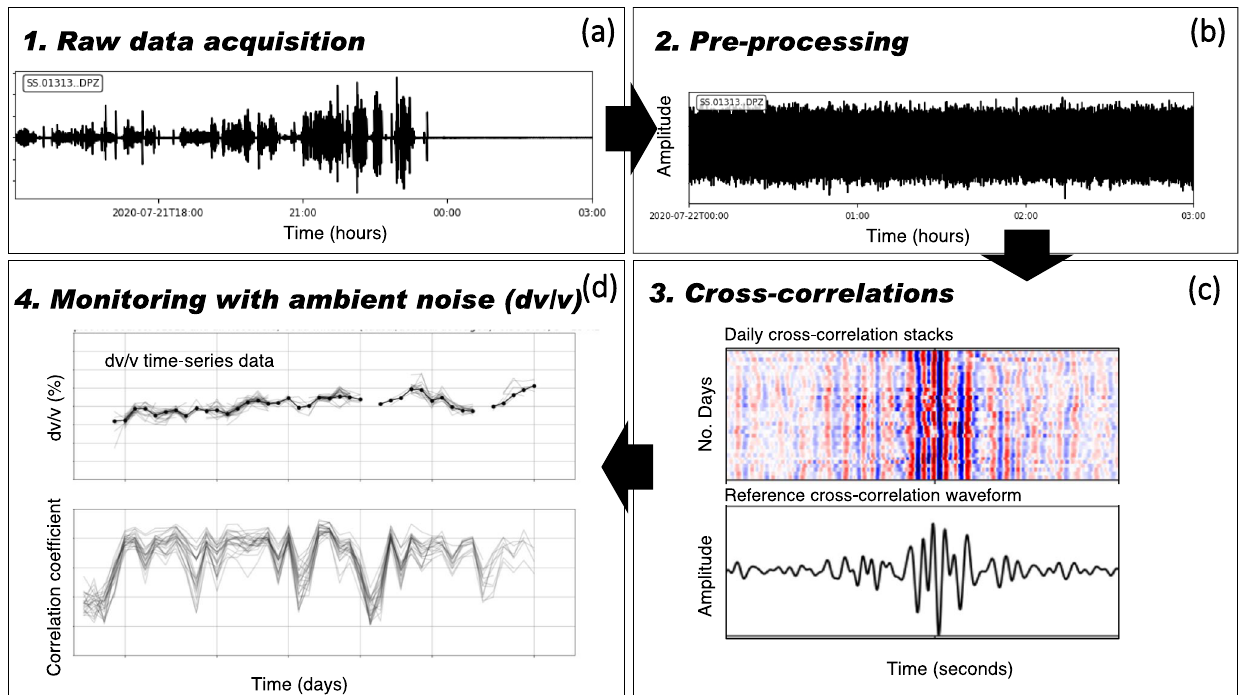
Fig. 6 Schematic showing the seismic data processing steps applied. a Initial raw data acquisition includes both active and inactive construction periods. b Pre-processing described in Section 4, includes trimming, one-bit normalization and spectral whitening. c Daily cross-correlations are plotted as an image in the upper plot, with a reference cross-correlation shown below. d The dv/v time series data is obtained using a ‘ stretching ’ algorithm (upper plot), which also outputs a correlation coef fi cient representing the similarity between the daily waveform and reference waveform (lower ● Spectral whitening: Also known as frequency-domain normalization, spectral whitening broadens the frequency band of ambient noise and reduces the effect of monochromatic noise sources 54 .